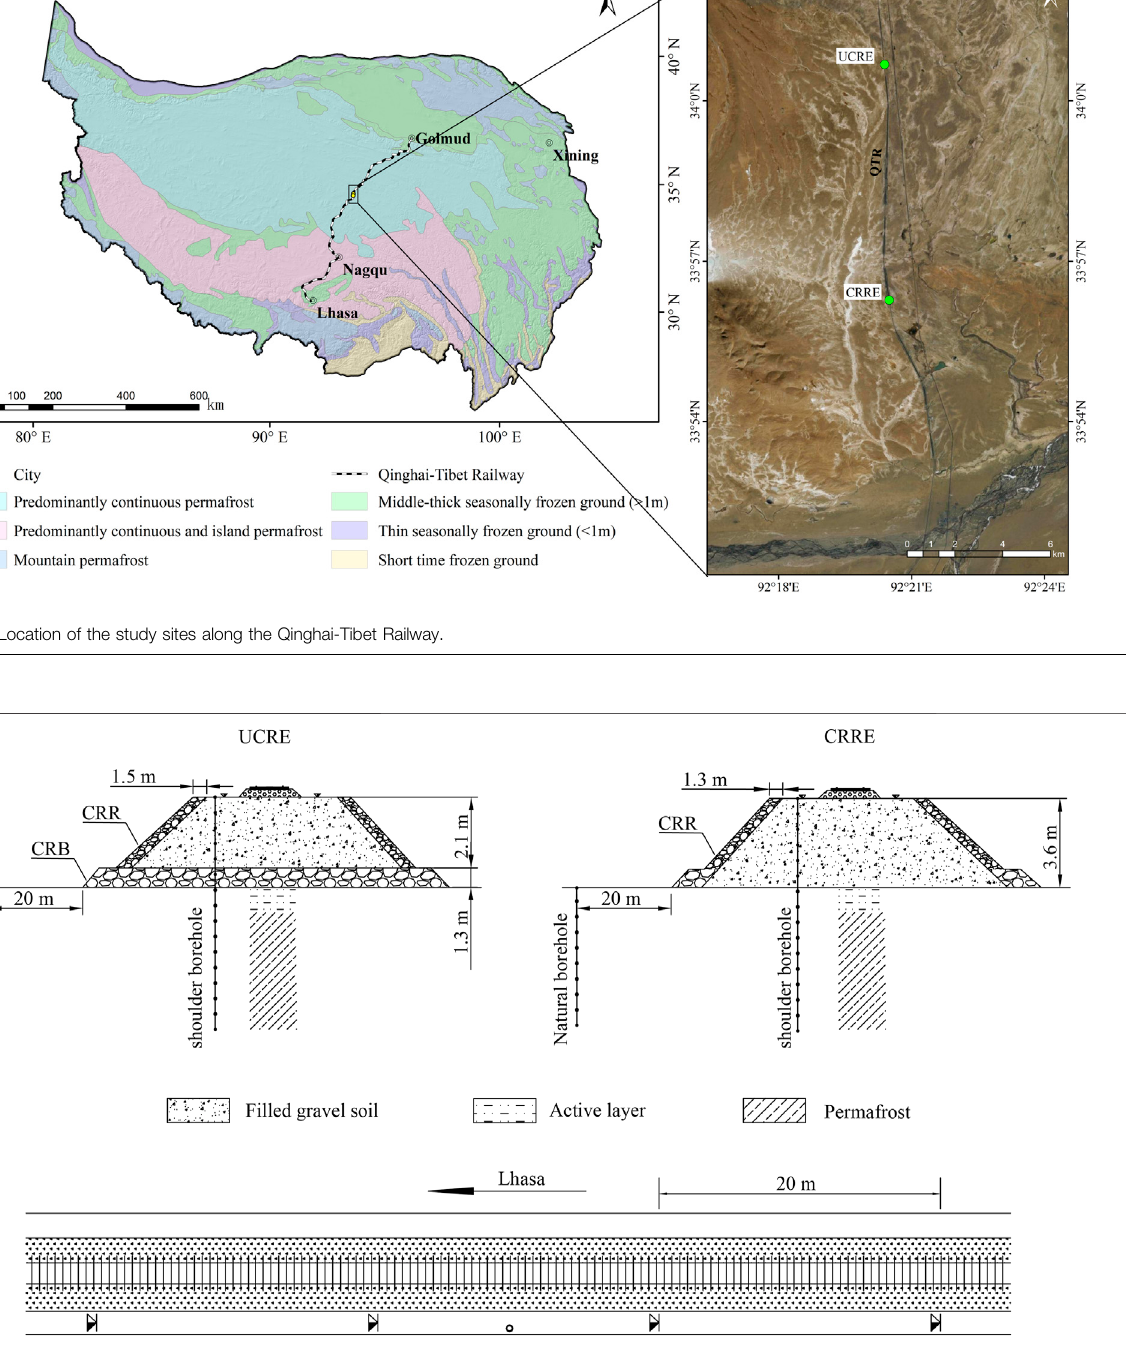
Frontiers in Earth Science |